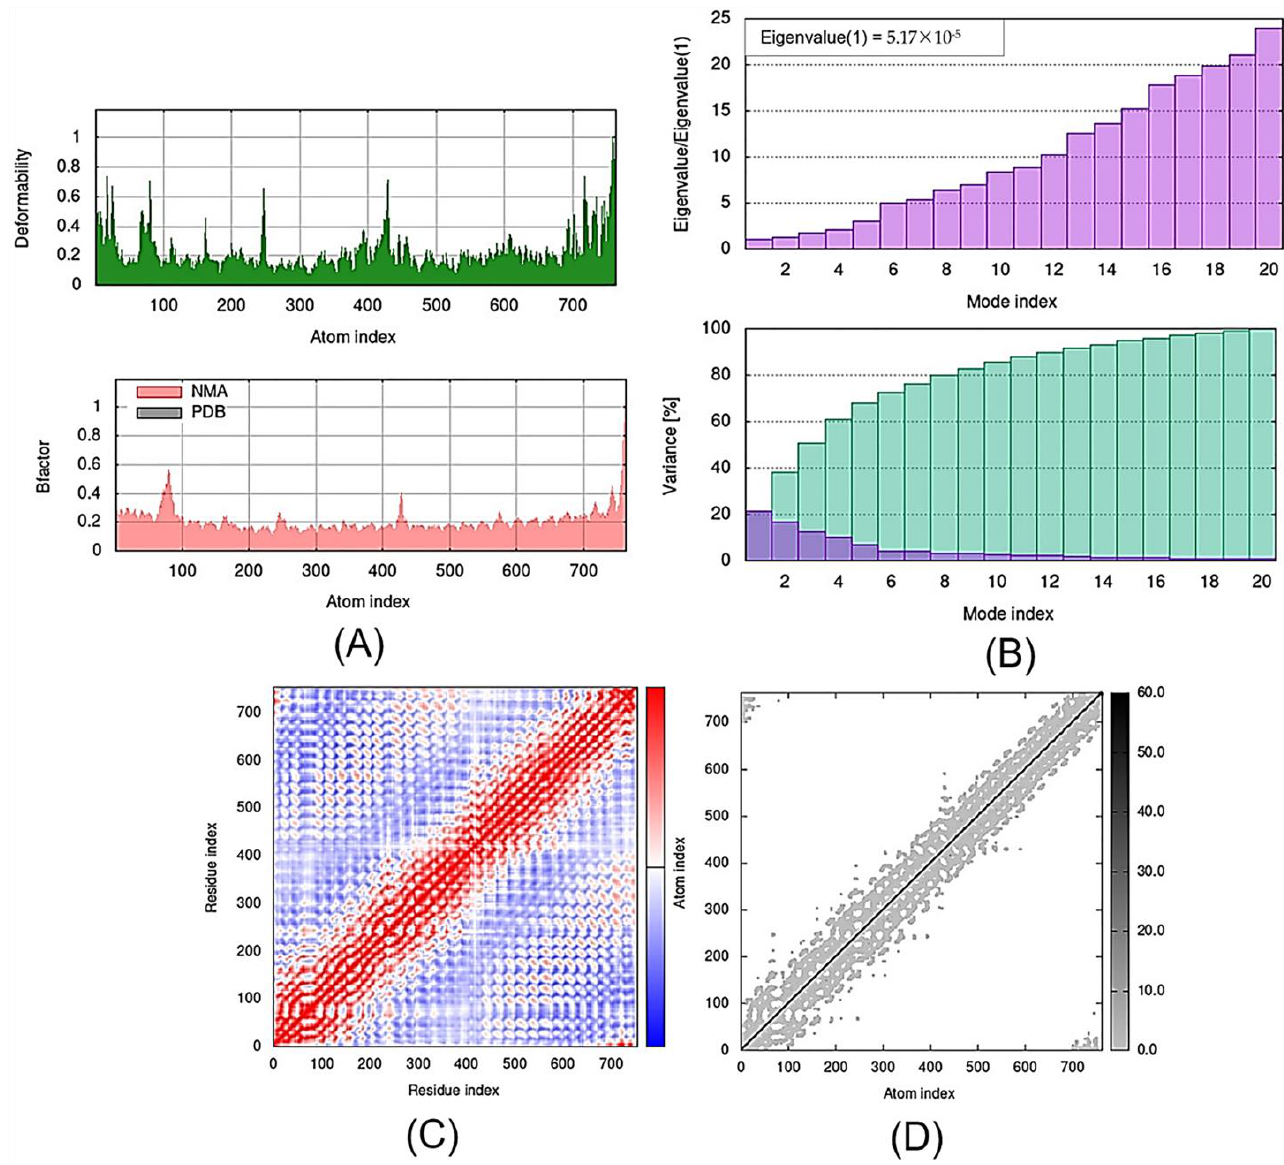
Figure 6. Outputs of molecular dynamics simulations in iMODS for SLIT1-TMZ: ( A ) deformability and B-factor plot; ( B ) eigenvalue and variance plot; ( C ) elastic network model; and ( D ) covariance map.